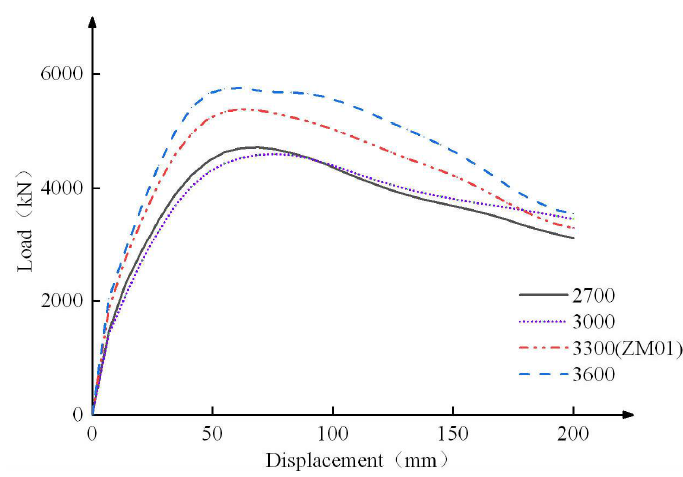
Figure 17. Influence of the size of column cap.